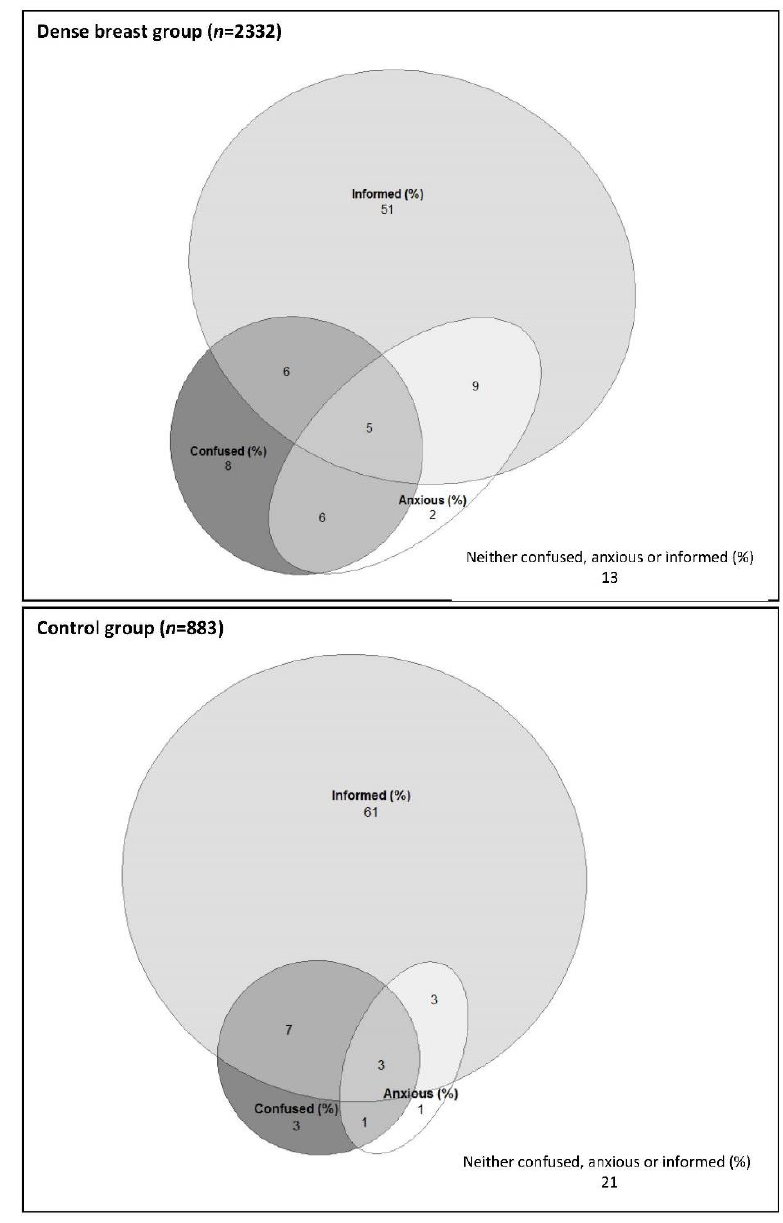
Figure 2. Venn diagrams showing percent of woman reporting feeling informed, confused and anxious for notified women ( n = 2332) and controls ( n = 883) (only respondents with complete responses for the three relevant questions are included here).